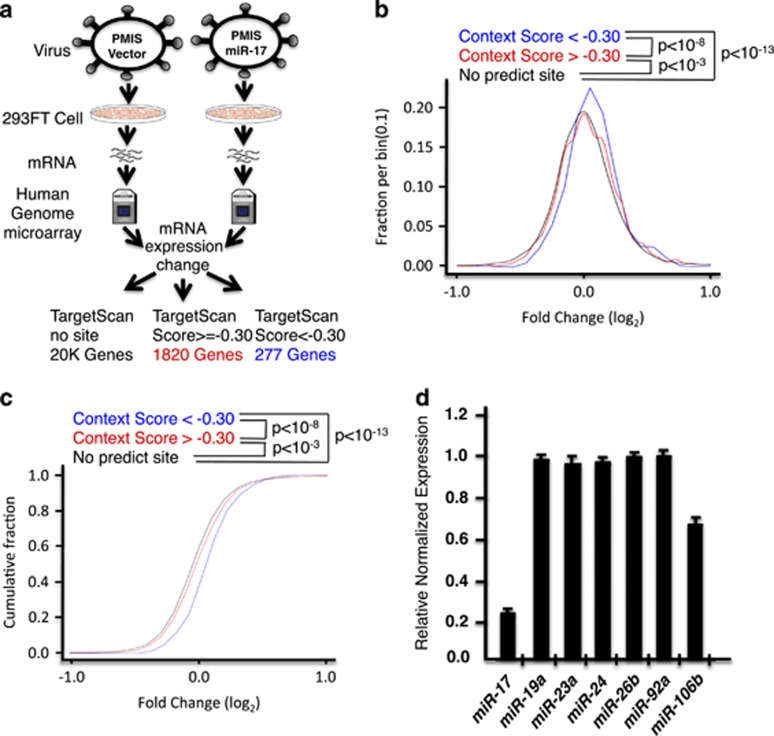
Genome-wide analyses of PMIS-miR-17 function. (a) Experiment design for the whole-genome-wide analysis of mRNA change after transduction with PMIS-miR-17. (b and c) Changes in abundance of mRNAs in PMIS-miR-17-expressing 293 cells were monitored by microarrays. TargetScan was used to predict miR-17 targets. We further separate miR-17 targets into two groups, one with context+ score <−0.30 and the other with context+ score >−0.30. Distributions of changes (0.1 unit bins) for mRNA UTRs containing no site in black line, site with score >−0.30 in red line and site with score <−0.30 in blue line. Upregulation of mRNAs with context+ score <−0.30 was significantly more than that from mRNAs with no site (P<10−13, one-sided K–S test). Comparisons between mRNAs with context+ score <−0.30 versus context+ score >−0.30, context+ score >−0.30 versus no site were also significant (P<10−8, P<10−3, respectively). (d) The 293 cells were transduced with PMIS-miR-17, total RNA harvested and randomly selected miR expression was analyzed by RT-PCR using Taqman probes (N=3).